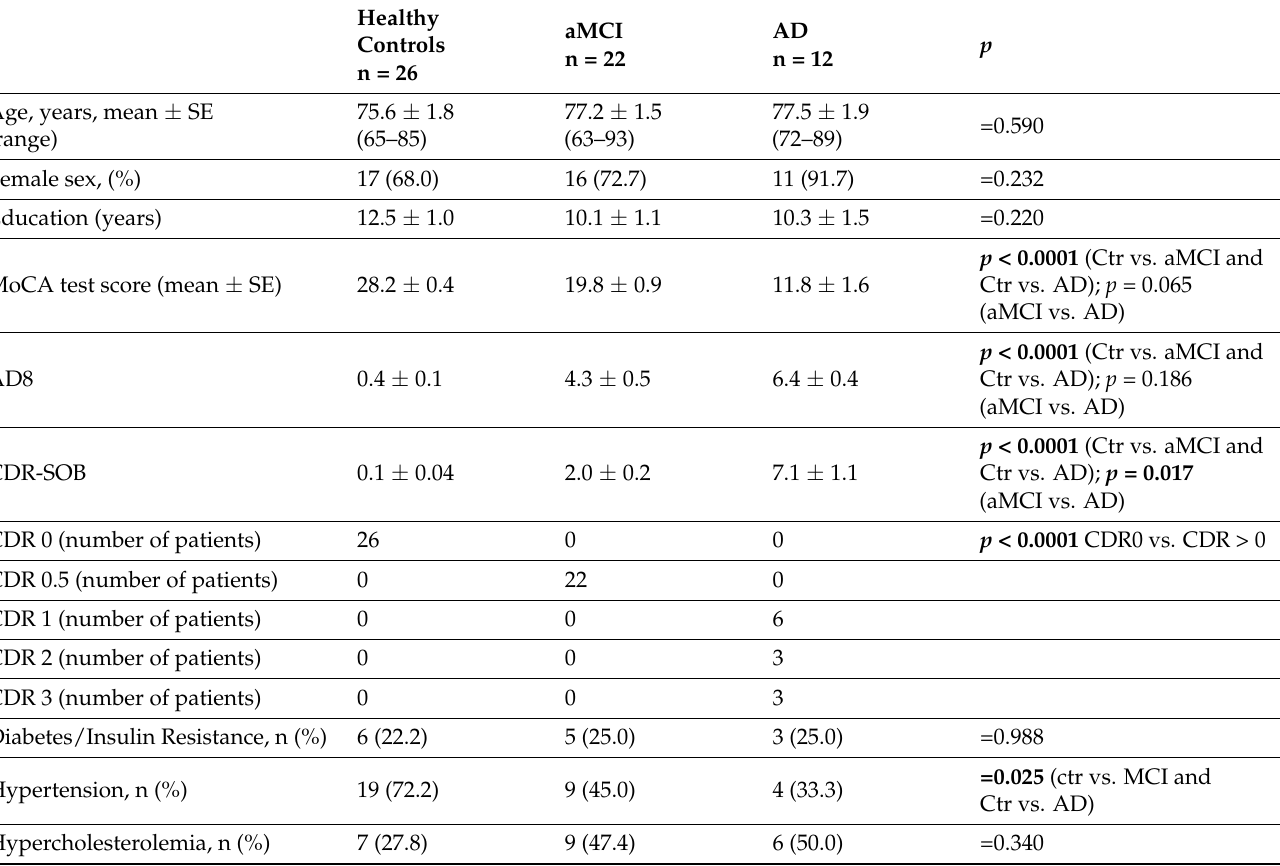
Table 1. Demographic data of healthy controls, aMCI and AD patients in the